Question: Write a single sentence explaining what this figure depicts.
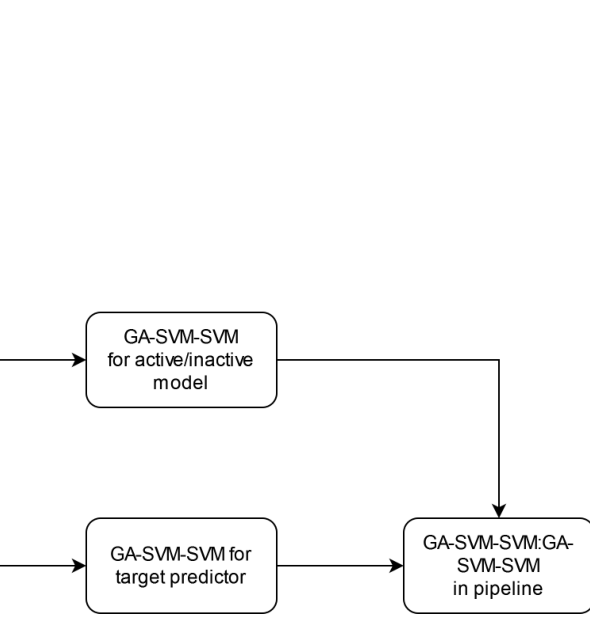
Answer: The flowchart of these procedures.